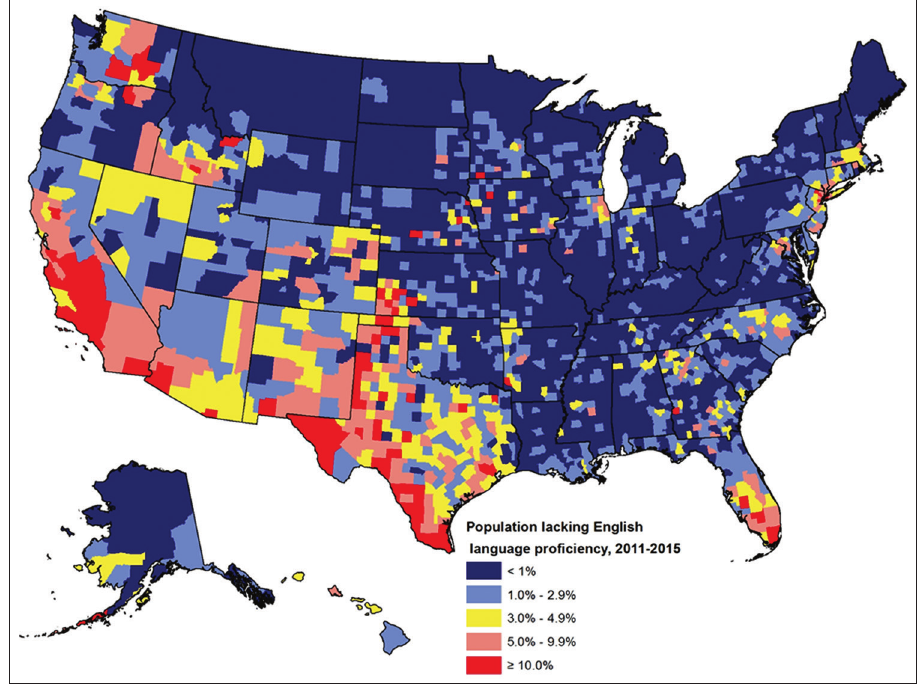
Fig ure 5. Population Lacking English Language Proficiency (Percentage of Population Aged 5 Years and Older Speak - ing English Not Well or Not At All), United States, 2011-2015 (3,143 Counties) Source: Data derived from the 2011-2015 American Community Survey.